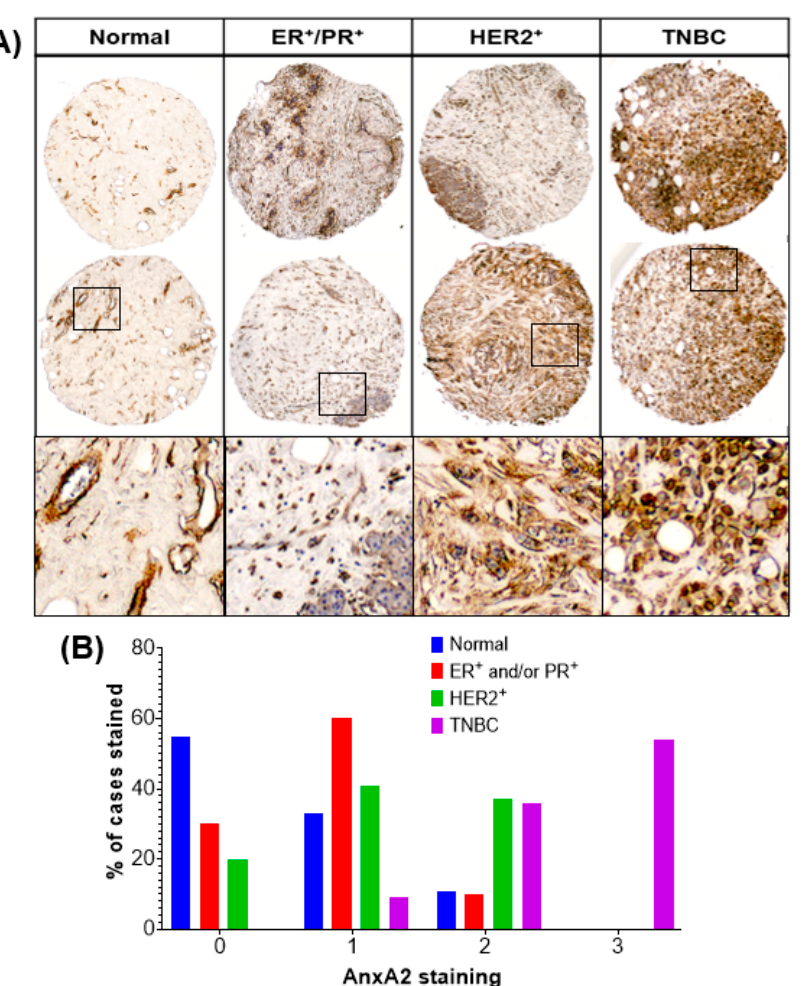
Figure 1. Immunohistochemical analysis of AnxA2 expression in different subtypes of breast cancer tissue and normal breast tissue specimens. ( A ) Paraffin embedded tissue sections were stained with AnxA2 monoclonal antibody. Representative images of normal, ER + /PR + , HER2 + , and TNBC tumor tissue specimens showing status of AnxA2 expression. AnxA2 was primarily localized to the plasma membrane of tumor cells in TNBC specimens. ( B ) Bar chart showing the AnxA2 staining patter in normal and different subtypes of breast cancer tissue specimens (Chi square test: χ 2 = 50.54, p <